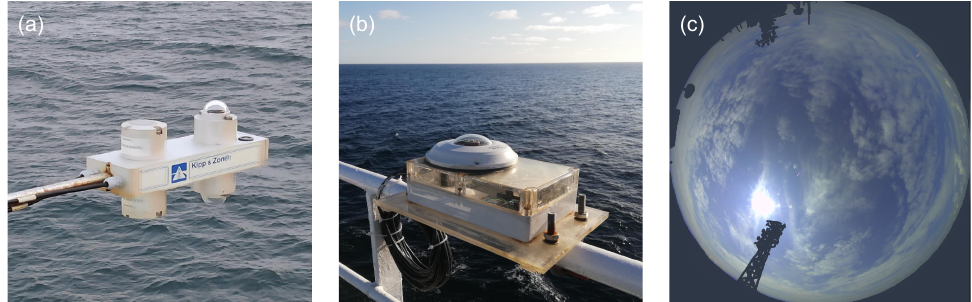
Figure 1. Equipment we used to collect the data, and an example of all-sky optical imagery over the ocean: ( a ) radiometer Kipp and Zonen CNR-1; ( b ) cloud-camera SAILCOP [13]; ( c ) an all-sky photo with its mask covering the structures of the